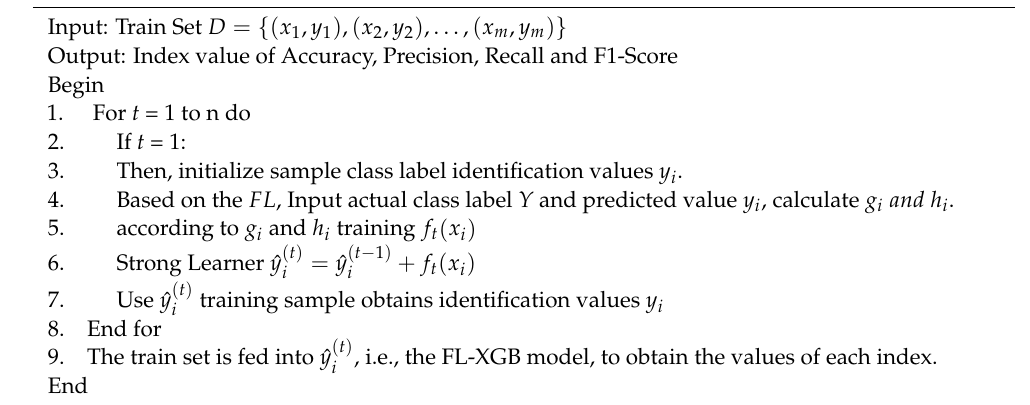
Algorithm 1: FL-XGB-VPN-Encrypted Traffic Identification